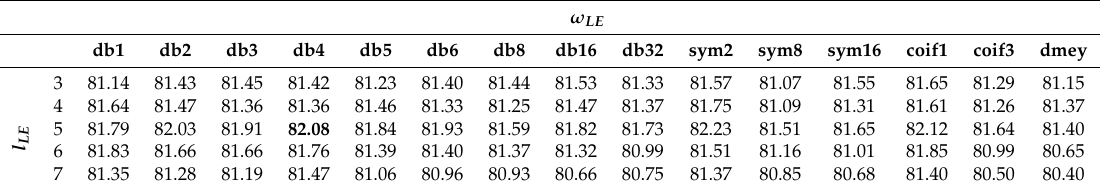
Table 23. The accuracy (%) of four class sleep stage classification with different ω LE and l LE under AASM standard.